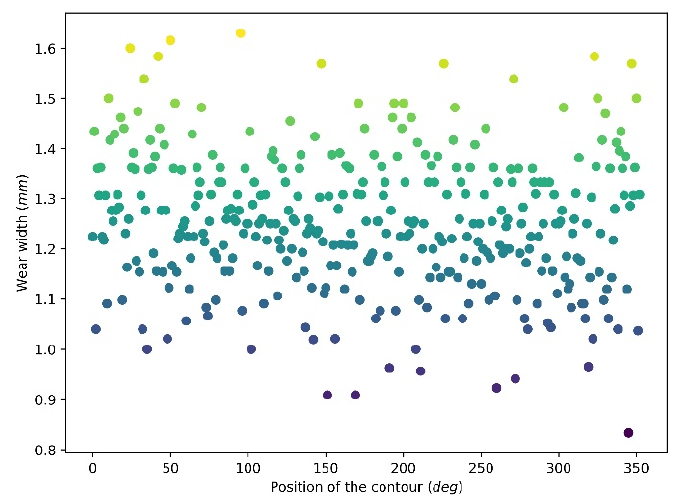
Figure 11. Wear width distribution after 10 revolutions.